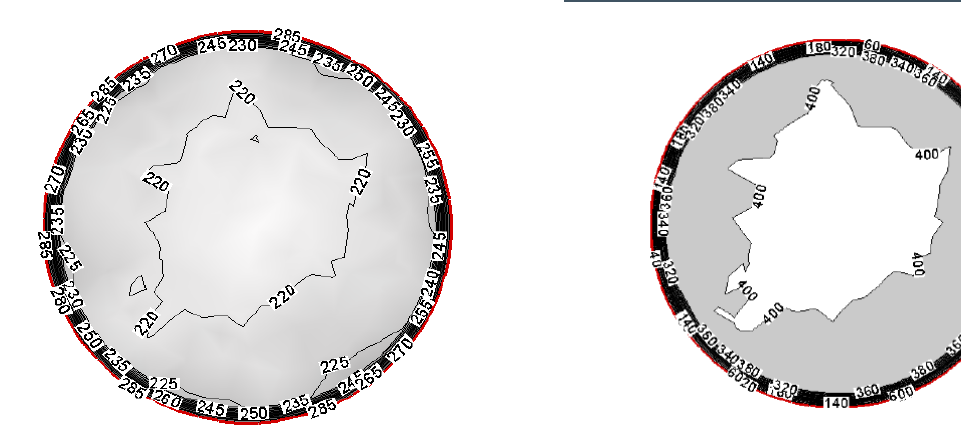
Figure 11. Contours of temperature distribution at 0.2 cm along ax- ial direction from the inlet nozzle in cold end at 5 bar inlet pressure.